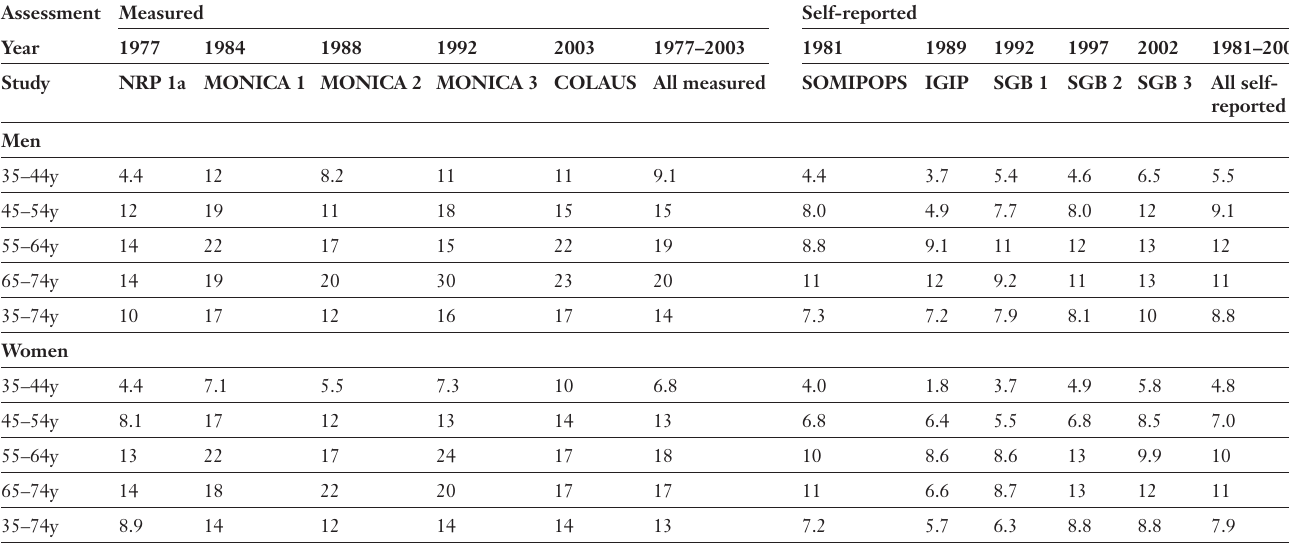
Prevalence (%) of obesity in studies with measured and self-reported BMI by